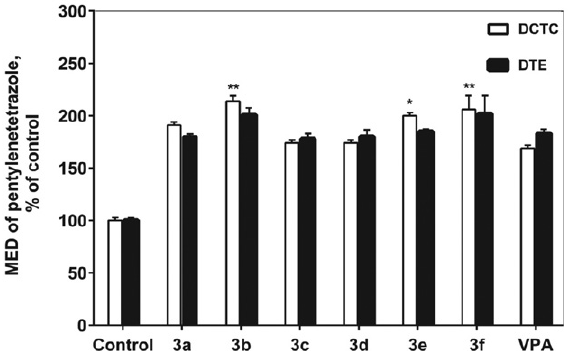
Figure 2 . Anticonvulsant activity of compounds 3a-f at 24 h after oral administration. Values are given as mean ± SEM, n = 5 mice; for all groups p < 0.01 compared with control; * p < 0.05 and ** p < 0.01 compared with